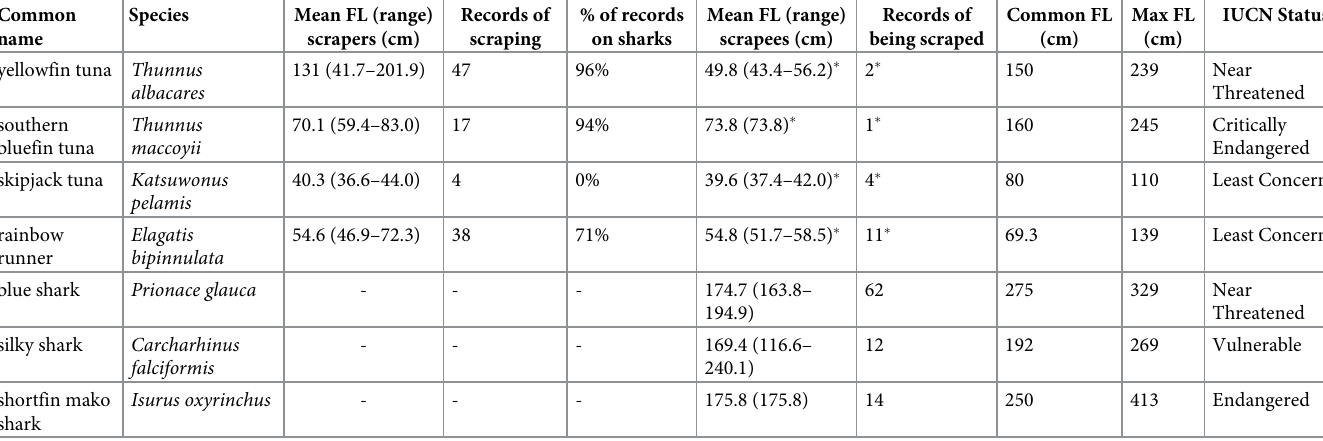
Table 1. Details of scraper and scrapee species